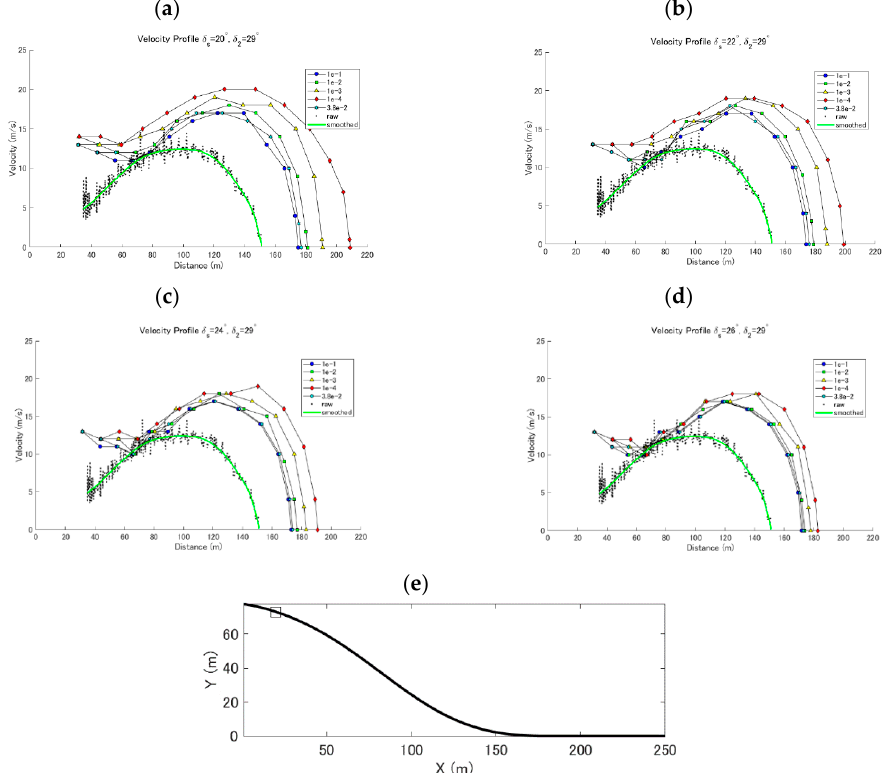
Figure 9. Comparison of the flow front velocity in the case of δ 2 = 29°. ( a ) δ s = 20°, ( b ) δ s = 22°, ( c ) δ s = 24°, and ( d ) δ s = 26°. In each graph, the simulation results of d = 10 cm (blue circle), d = 3.8 cm (sky blue star), d = 1 cm (green square), d = 1 mm (yellow triangle), and d = 0.1 mm (red diamond). Raw (black dots) and smoothed (green line) experimental results are included. ( e ) The slope profile used to simulate the ping-pong ball simulations. A square in the slope figure shows the position of the ping- pong ball container. Raw and smoothed data of front velocity are from [8].